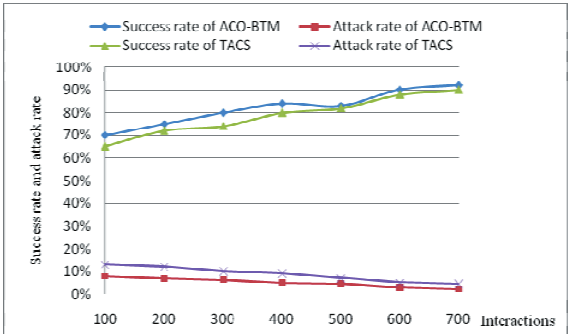
Fig. 4. The performance comparison between ACO-BTM and